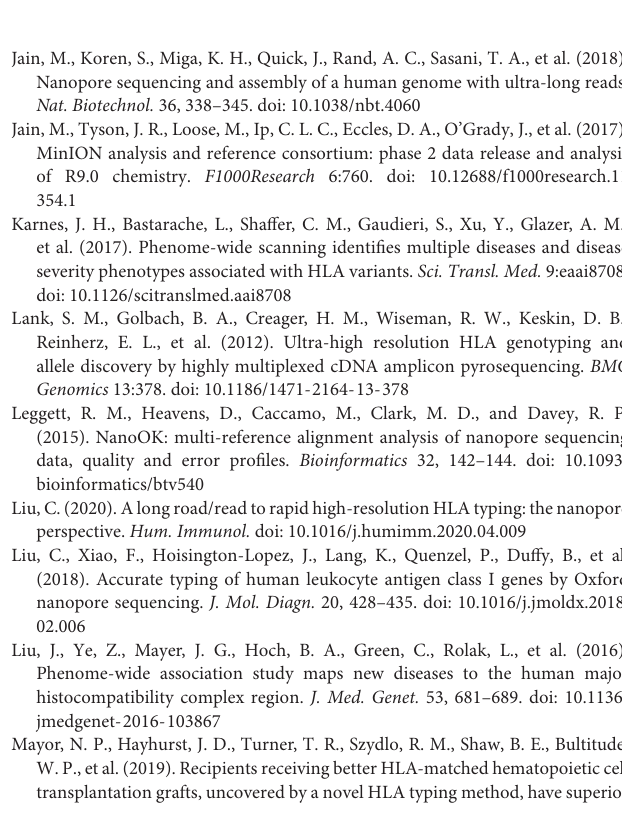
Supplementary Figure 1 | Binding sites of HLA gene-specific primers. Supplementary Figure 2 | Sequencing coverage graph for class I and class II in the SeqPilot interphase. Supplementary Table 1 | List of primer sequences. Supplementary Table 2 | Alleles of 12 classical HLA genes of 50